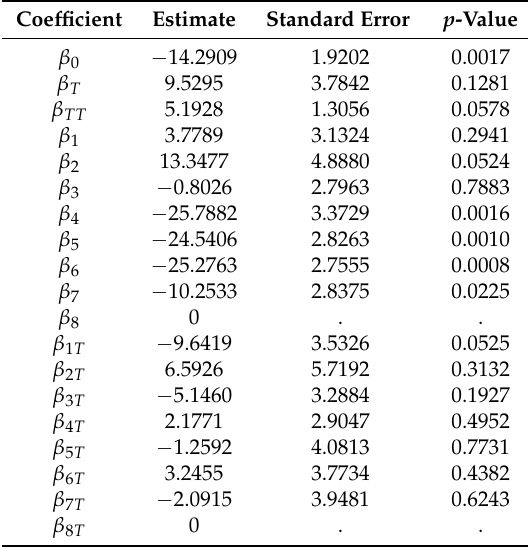
Table 3. GLS estimates for fixed effects of Model (5) related to NO 2 .